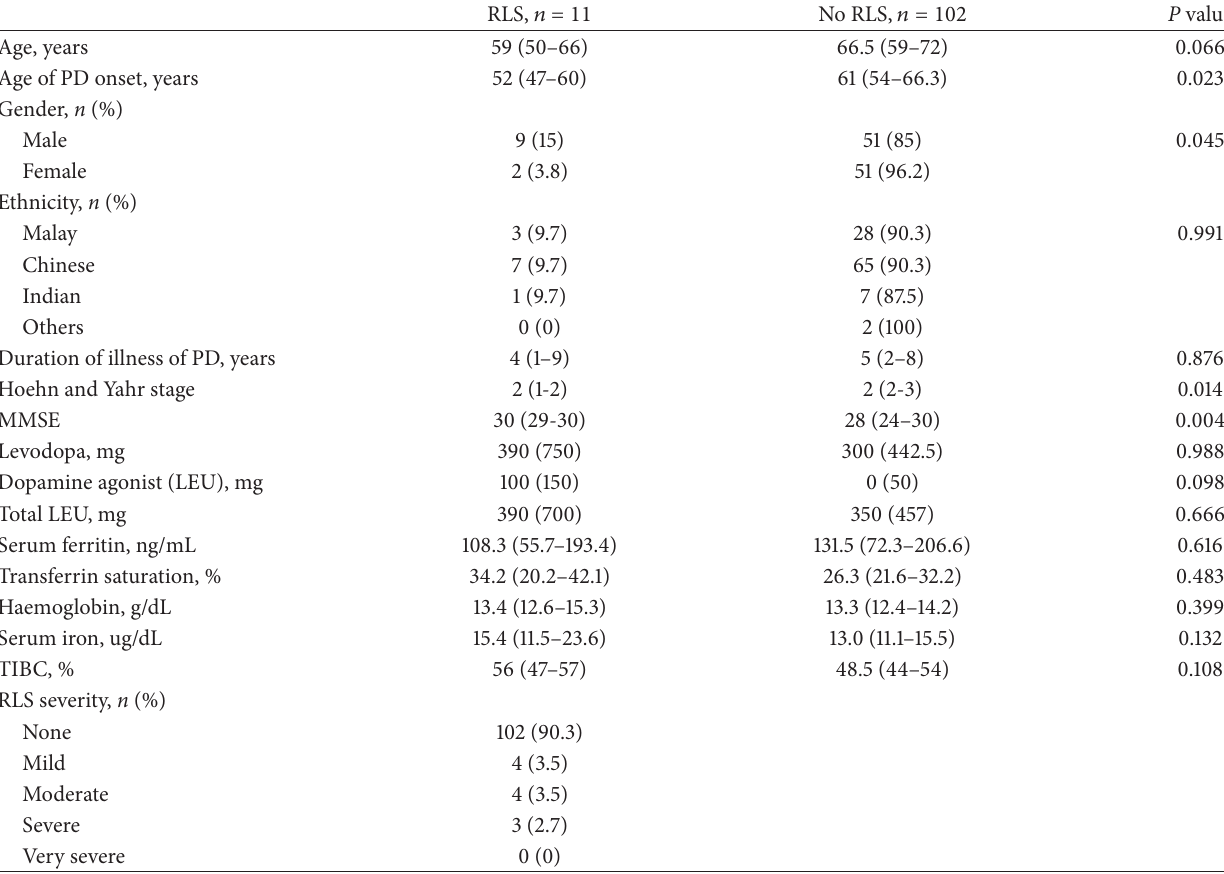
Table 2: Comparison of PD patients with and without